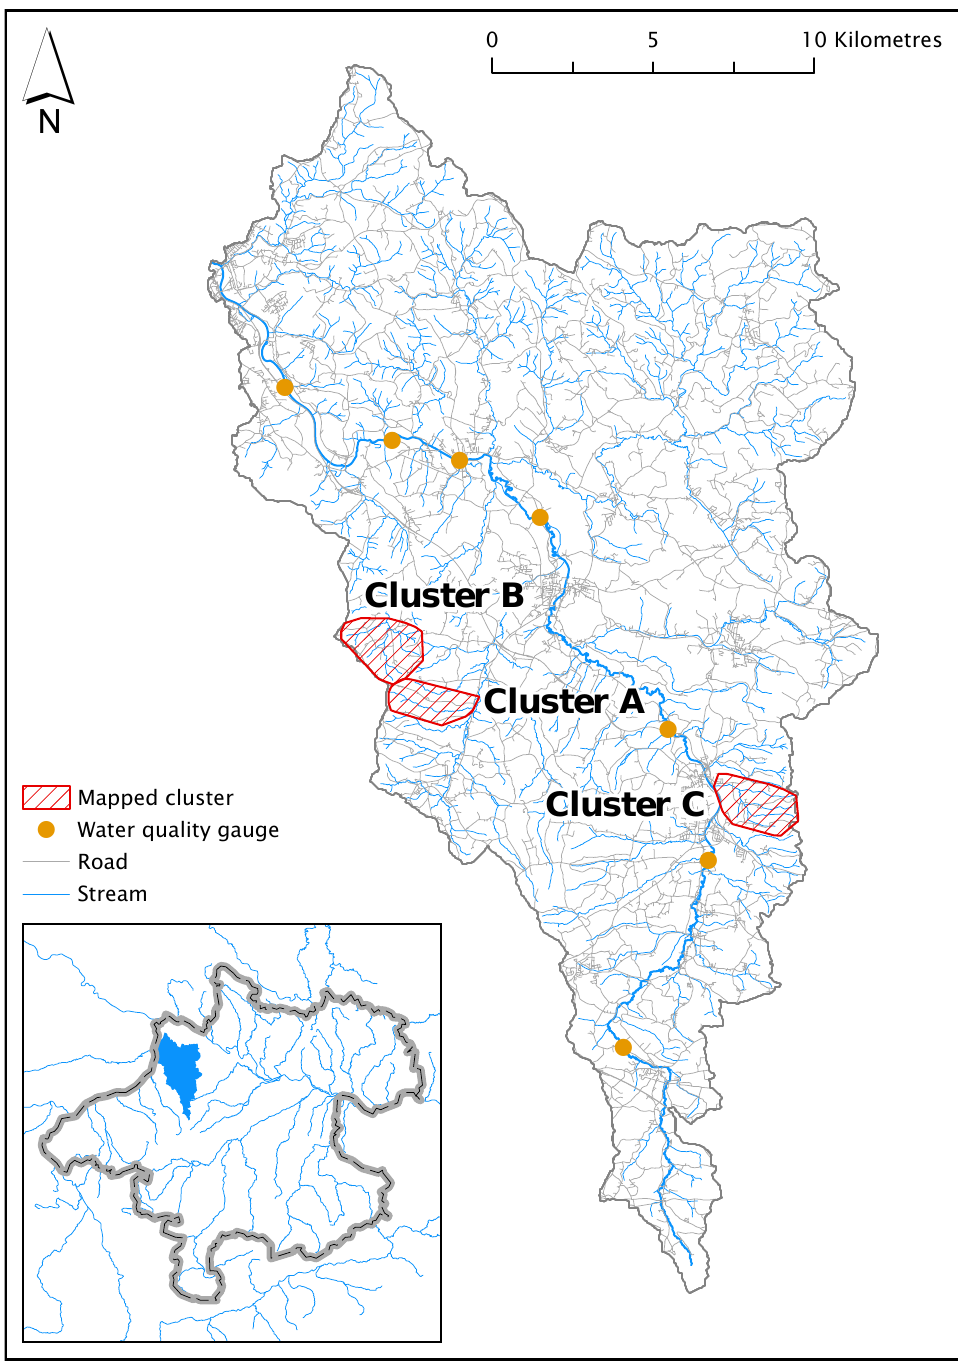
Figure 2. The case study catchment with the three randomly selected and systematically mapped clusters as well as the seven water quality gauges along the river Pram used for calibrating